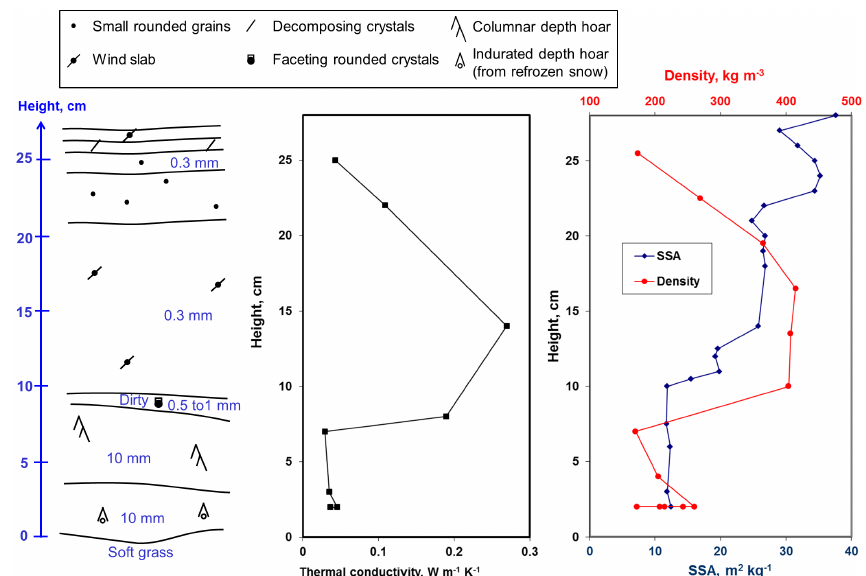
Figure 2. Stratigraphy and vertical profiles of snow physical properties near our study site on 12 May 2015. Visual grain sizes are indicated in the stratigraphy. Density data are for the middle of the 3cm high sample. Snow type symbols are those of Fierz et al. (2009), except for the basal melt–freeze layer, which transformed into depth hoar to form an indurated layer, as detailed in the